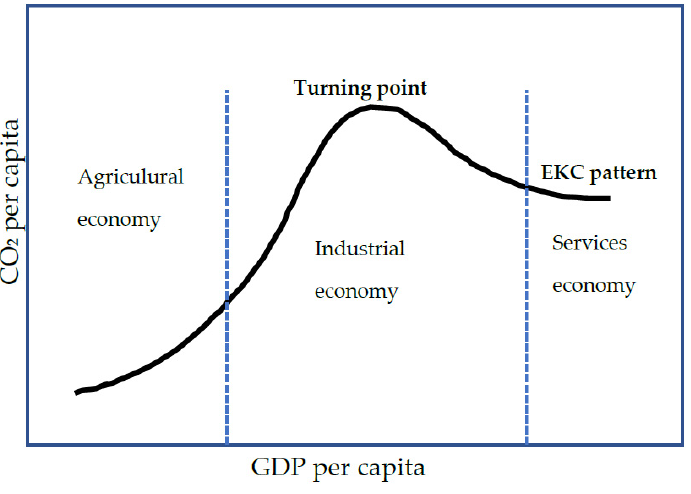
Figure 1. The EKC theoretical framework.